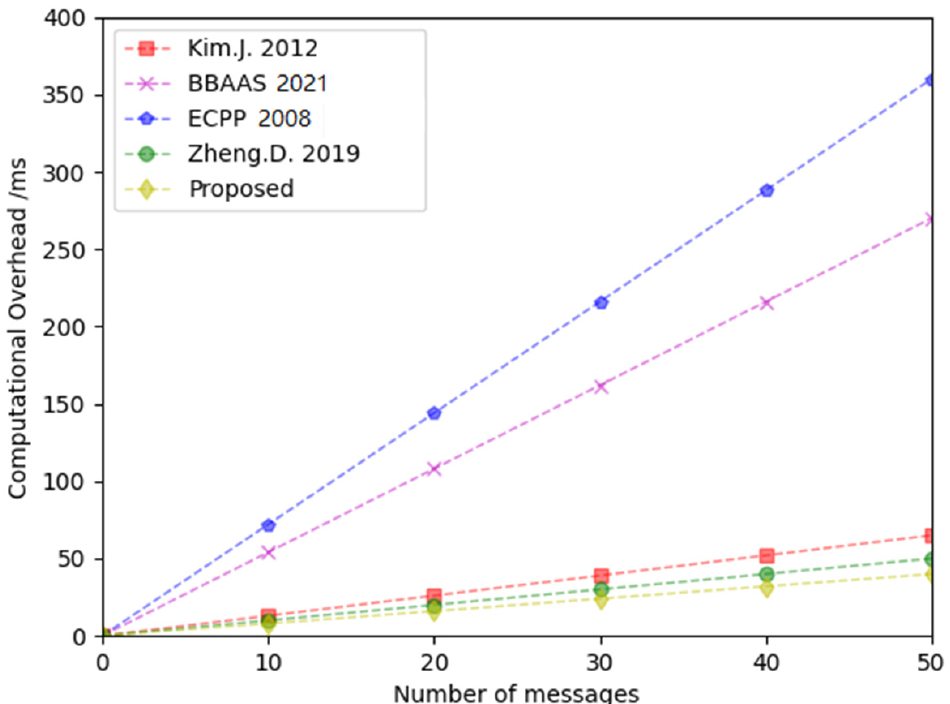
Figure 6. Computational Overhead of Vehicles in the Pre-certification Process [15,21,23,24]. We compared the computational overhead of the target RSU in the handover authenti- cation phase. For the target RSU, the computation overheads of the five schemes show a linear growth trend with the increasing number of handover messages. References [23,24] do not use pre-authentication for handover authentication, so the computational overhead of the target RSU is 16.88 ms and 10.814 ms, respectively. Only [15,21] and this paper use pre-authentication for fast handover authentication. In reference [15], one symmetric encryption and two elliptic curve point multiplication operations are required for handover authentication, so the computational overhead of the target RSU in reference [15] is 0.652 ms. In [21], the computational overhead of the target RSU is 5.67 ms. In this paper, the target